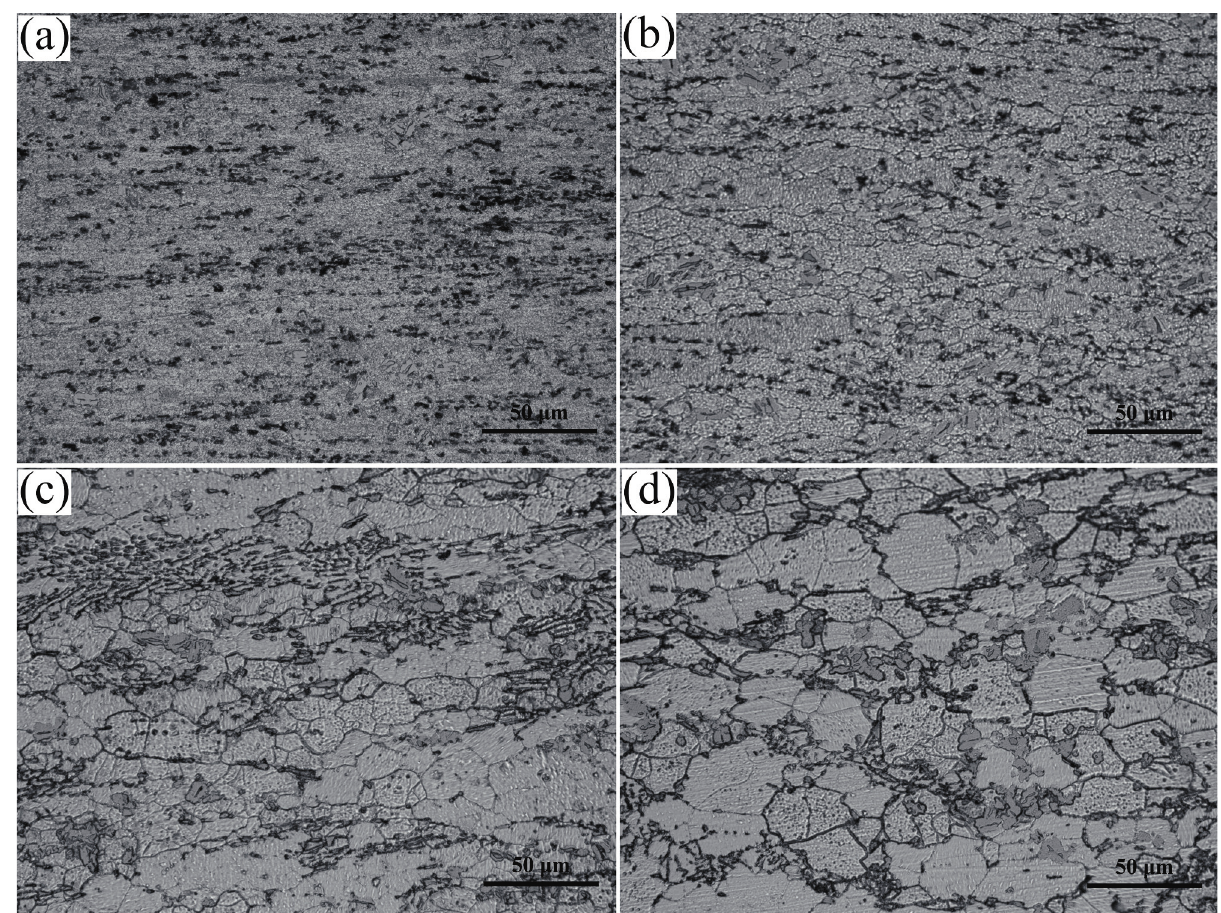
Fig. 6: Optical deformed microstructures of alloy 2618-Ti under different conditions: (a) T = 350 °C, ε = 1 s − 1 ; (b) T = 400 °C, ε = 0.1 s − 1 ; (c) T = 450 °C, ε = 0.01 s − 1 ; (d) T = 500 °C, ε = 0.001 s −